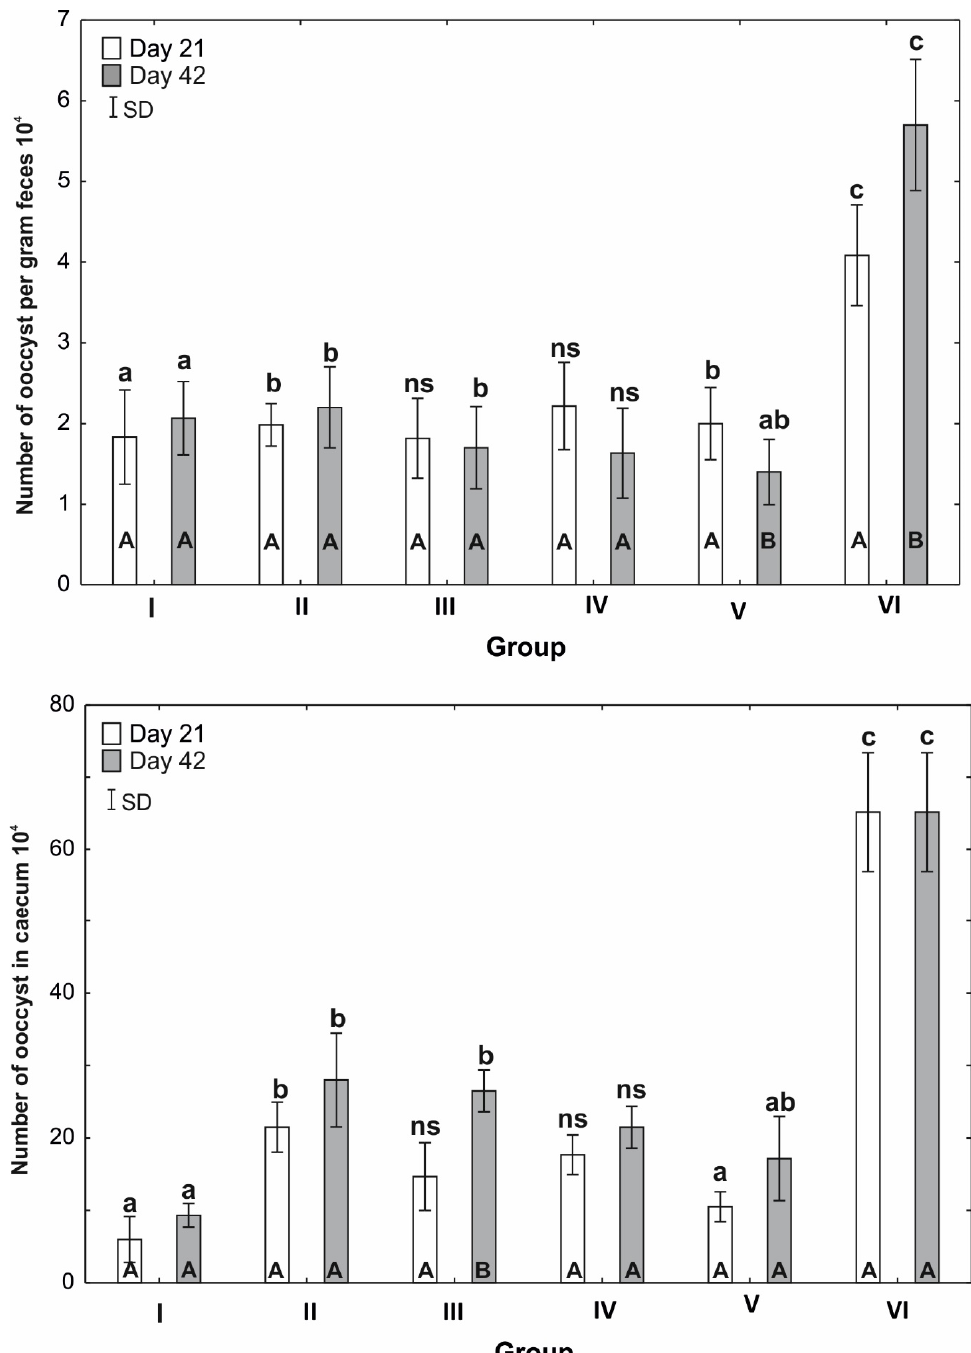
Figure 3. Results of the Kruskal–Wallis one-way ANOVA test (lowercase letters—a, b, c) and the Mann–Whitney U test (uppercase letters—A, B) for the number of oocysts per gram of faeces and the number of oocysts in the caecum of chickens at 21 and 42 days of age. Statistical differences ( p ≤ 0.05) are marked with different letters; ns—statistically non-significant differences. Group I